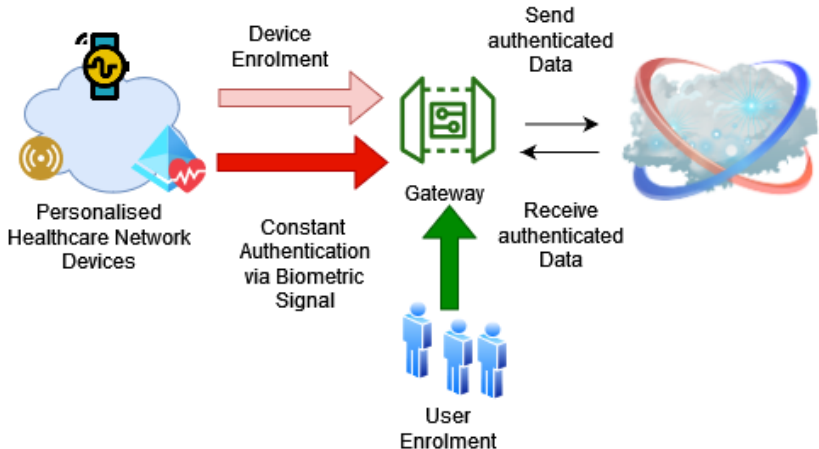
Figure 7. High-level Overview of the Proposed